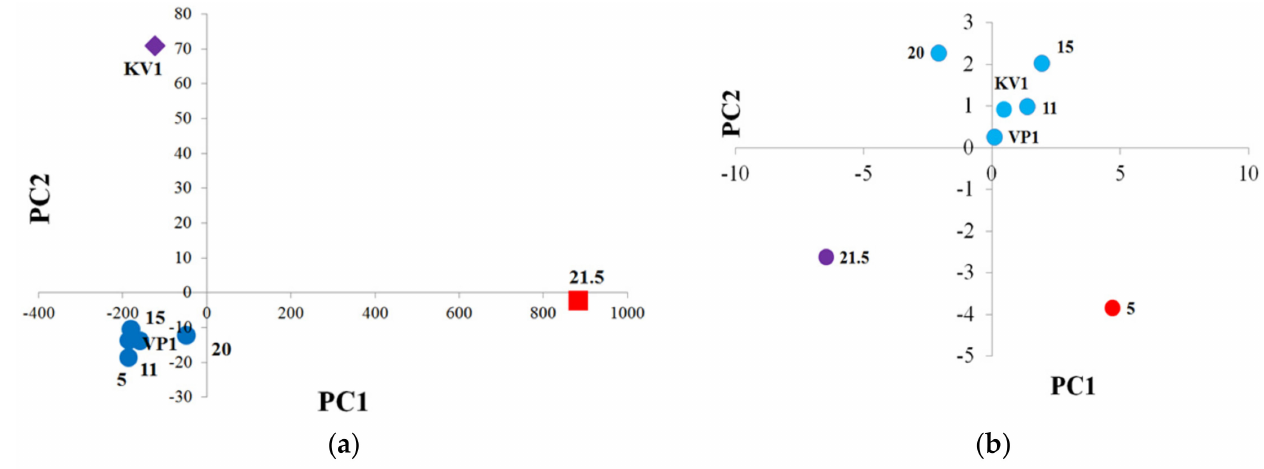
Figure 14. PCA of the sediment samples of the Cape Muostakh: ( a ) PCA with including all parameters—purple rhombus means sample "KV1", red square means sample "21.5", other samples are marked with dark blue circles (“5”, “11”, “15”, “20”, “VP1”); ( b ) PCA with including only the results of the pyrolytic methods of analysis—purple circle means sample "21.5", red circle means sample "5", other samples are marked with blue circles (“11”, “15”, “20”, “VP1”,